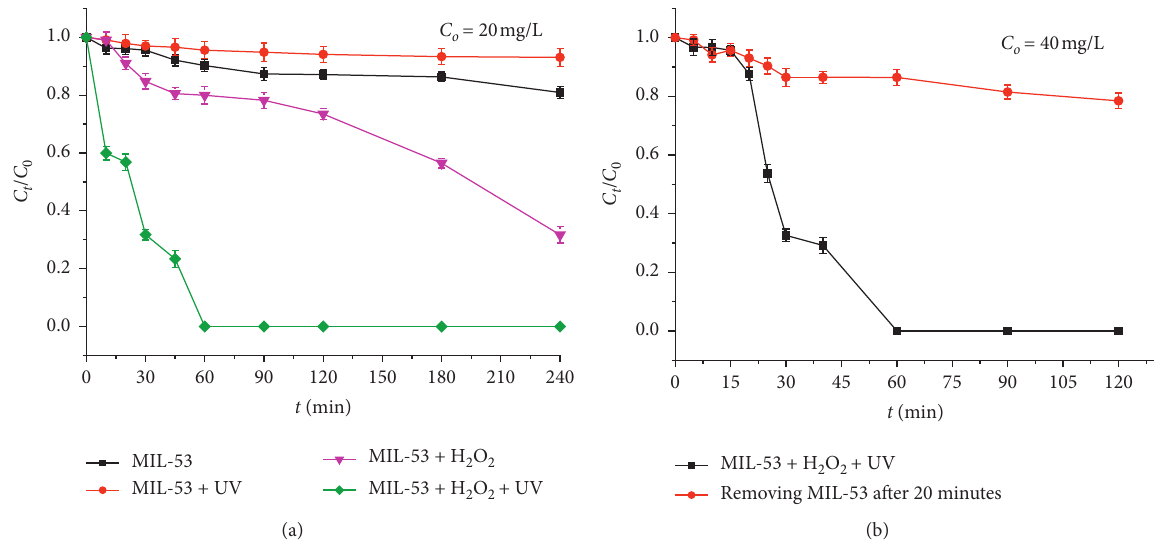
Figure 7: (a) Decomposition profile of MO under different conditions. (b) Leaching experiments (experimental conditions: 0.5g/L of the catalyst; 0.192M H 2 O 2 ; temperature: 30 °